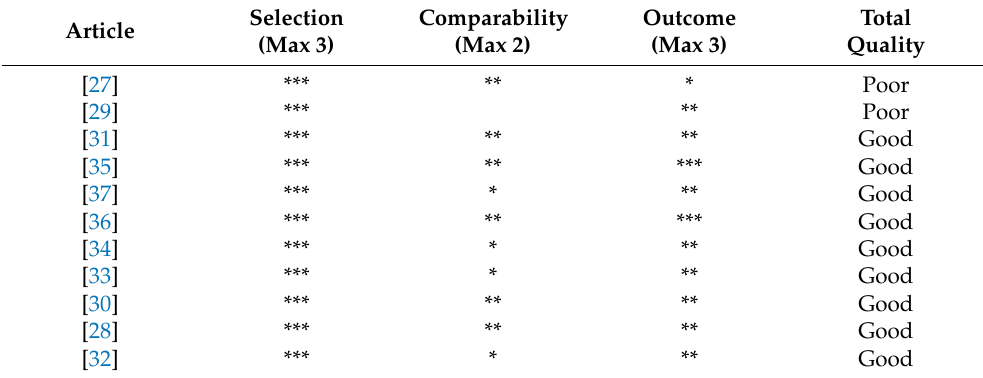
Table 3. Quality assessment based on Newcastle Ottawa